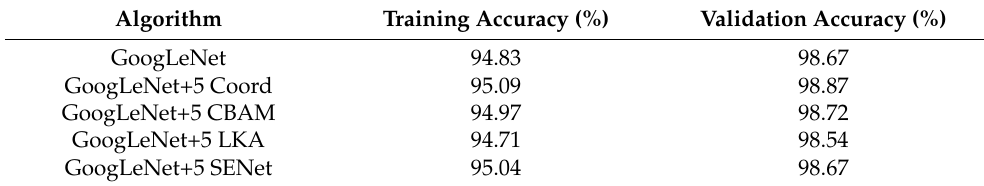
Table 4. The accuracy of the GoogLeNet+5 layers with different attention.